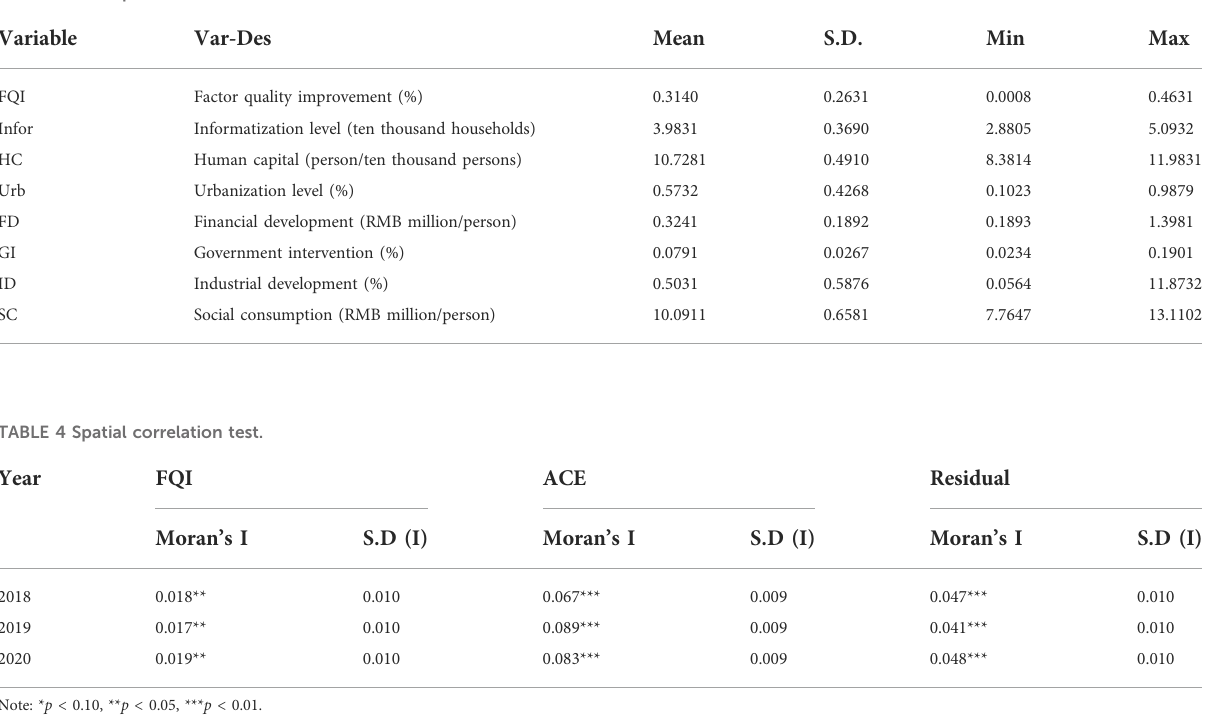
TABLE 3 Descriptive statistics of variables.